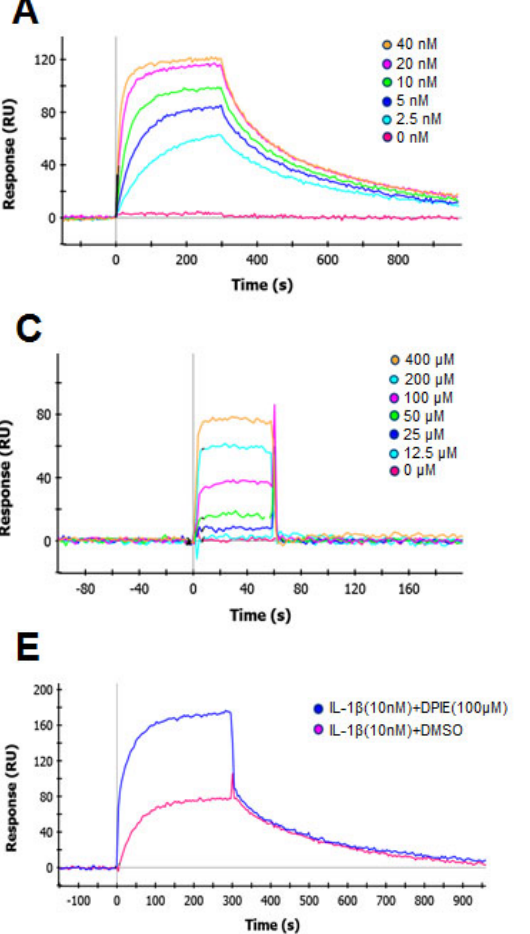
Figure 5. Global kinetic and equilibrium analysis of IL-1 β or DPIE bound to IL-1R1 immobilized on a biosensor surface. Binding of increasing concentrations of IL-1 β (2.5, 5, 10, 20, and 40 nM) to IL-1R ( A ) and its equilibrium analysis curve ( B ). Binding of increasing concentrations of DPIE (12.5, 25, 50, 100, 200, and 400 µ M) to IL-1R ( C ) and its equilibrium analysis curve ( D ). Binding of IL-1 β (10 nM) alone or IL-1 β and DPIE (100 µ M) to IL-1R1 ( E ). The dissociation constant (K D ) value derived from the global fit of a single binding experiment is indicated with the fitting error, shown in parentheses.